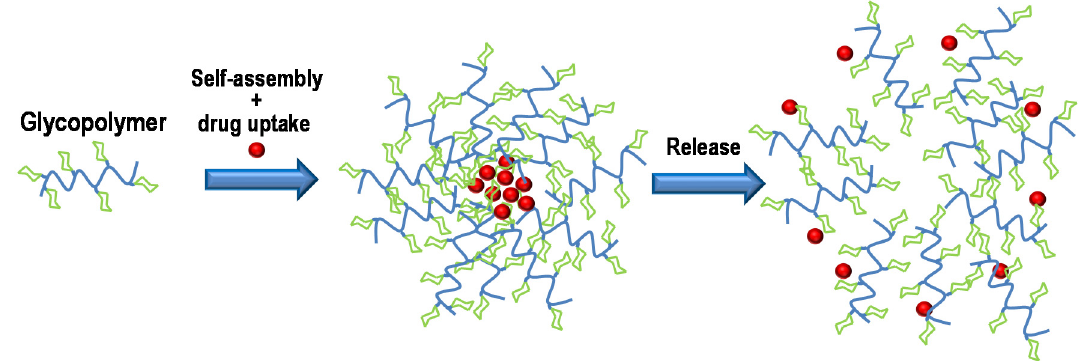
Figure 5. Scheme of glycopolymer self-assembly along with bioactive drug uptake and posterior release of the compound.